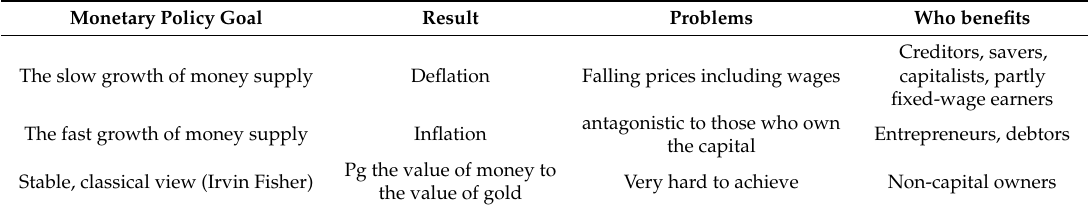
Table 2. Monetary policy